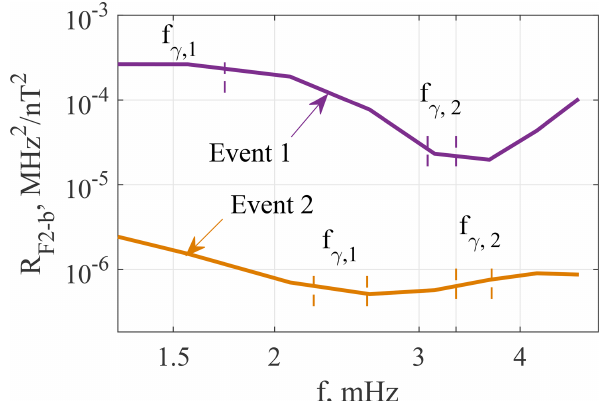
Figure 16. Comparison of (cid:49) fo F2 to b X PSD ratios R F2 − b for events 1 and 2. The bands of high (cid:49) fo F2- b X coherence are shown with vertical dashed